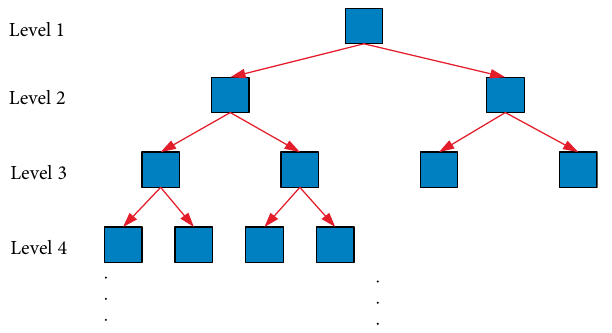
Figure 3: Schematic diagram of tree structure